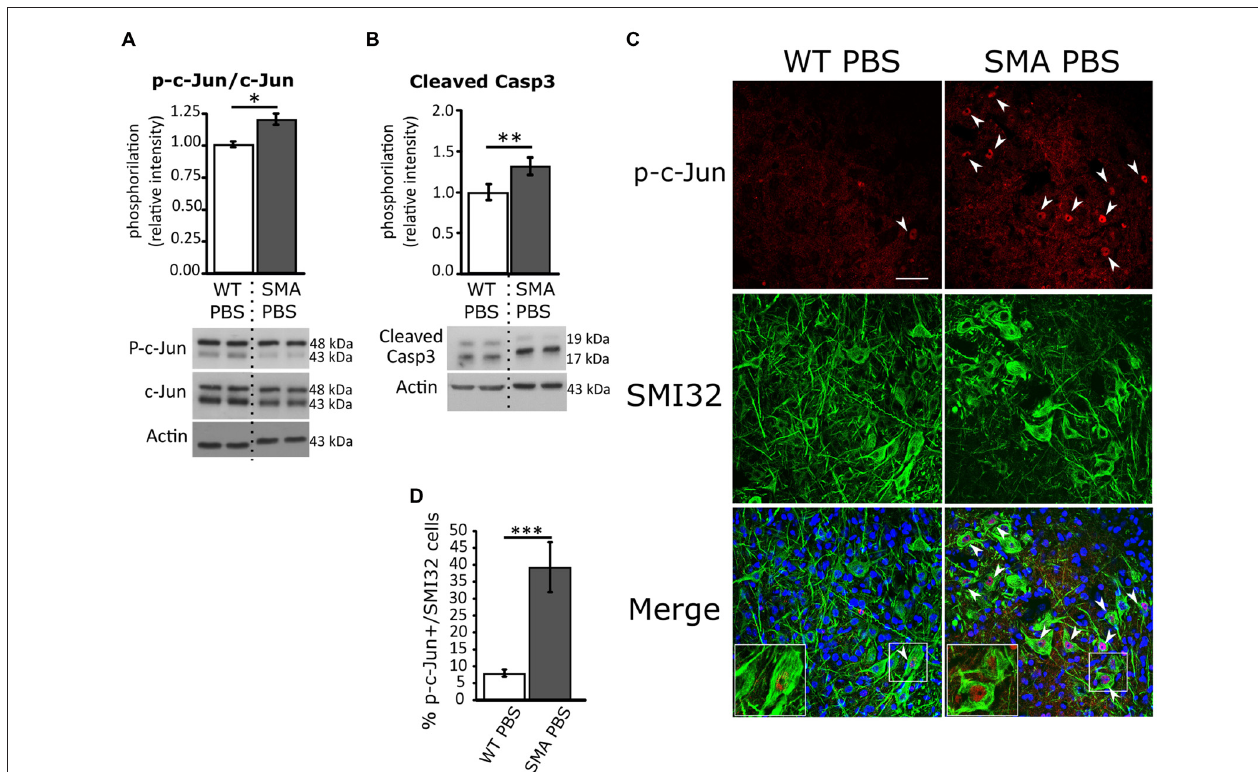
FIGURE 1 | Analysis of c-Jun and active Caspase-3 phosphorylation in WT and spinal muscular atrophy (SMA) pups. (A) Western Blot of the relative phosphorylation intensity of phosphorylated-c-Jun (p-c-Jun)/c-Jun signal in P12 WT and SMA PBS-treated animal spinal cord. (B) Western Blot of the relative phosphorylation intensity of active Caspase-3 signal in P12 WT and SMA PBS-treated animal spinal cord. Unprocessed original scans of blots are shown in Supplementary Figure S1 . (C) Confocal images showing p-c-Jun/SMI32-positive cells in the ventral horns of PBS-treated WT and SMA spinal cord. Upper panels show p-c-Jun positive nuclei (in red), indicated by arrowheads; central panels indicate SMI32-positive motor neurons (MNs; in green). In lower merge panels, the colocalization of p-c-Jun and SMI32 is displayed and, in addition, cell nuclei are labeled by DAPI staining (in blue): insets show higher magnification of p-c-Jun/SMI32-double labeled MNs. Scale bar 50 µ m. (D) Quantification of the percentage of MNs (SMI32+) expressing p-c-Jun in WT and SMA PBS-treated animals at age P12. ∗ P < 0.05; ∗∗ P < 0.01; ∗∗∗ P <